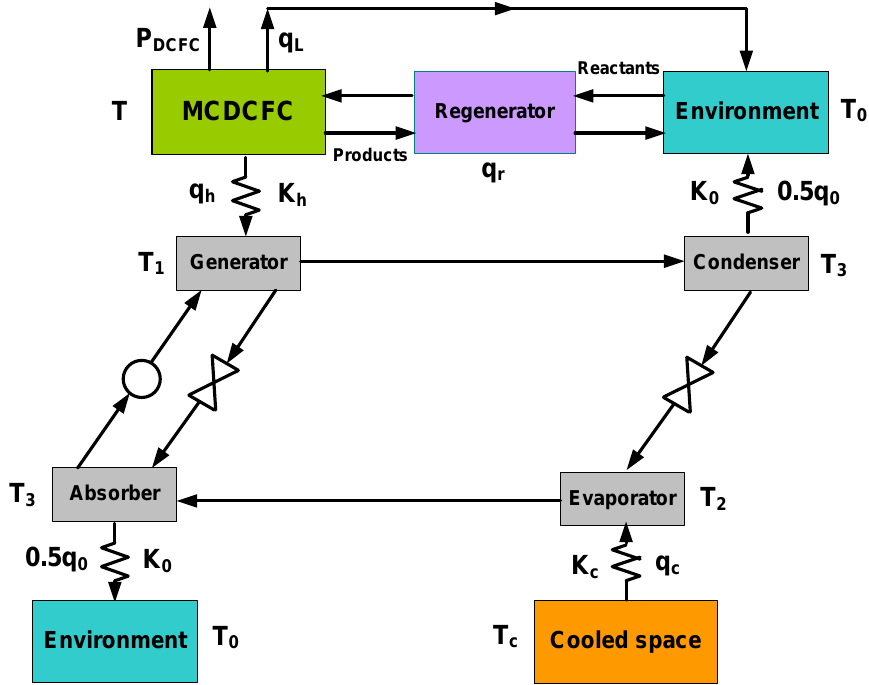
Figure 1. Schematic diagram of an MCDCFC/AR hybrid system.